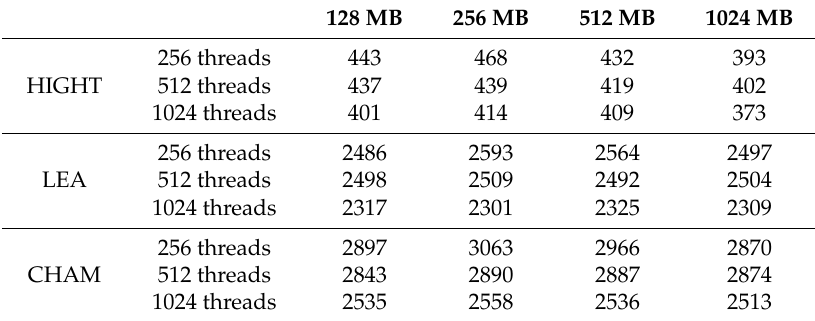
Table 4. Throughput by data size and the number of threads (Gbps) in RTX 2070.